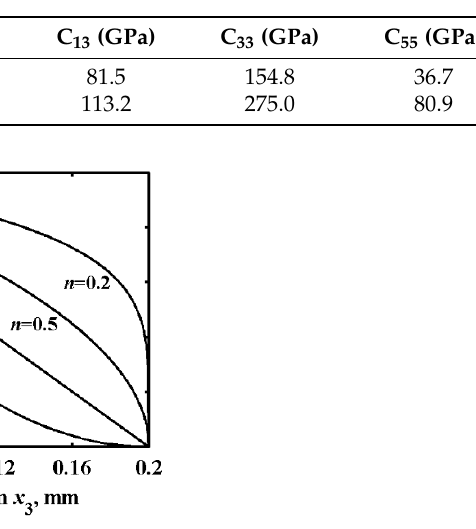
Table 1. Parameters of Cu and steel [20].